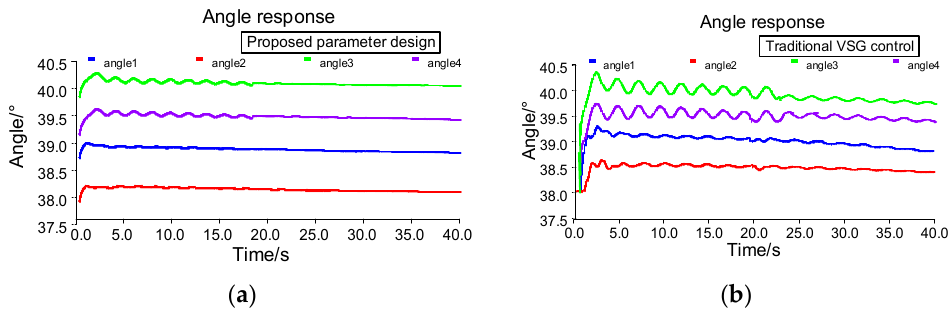
Figure 8. Dynamic response of inter-area power before/after optimization.